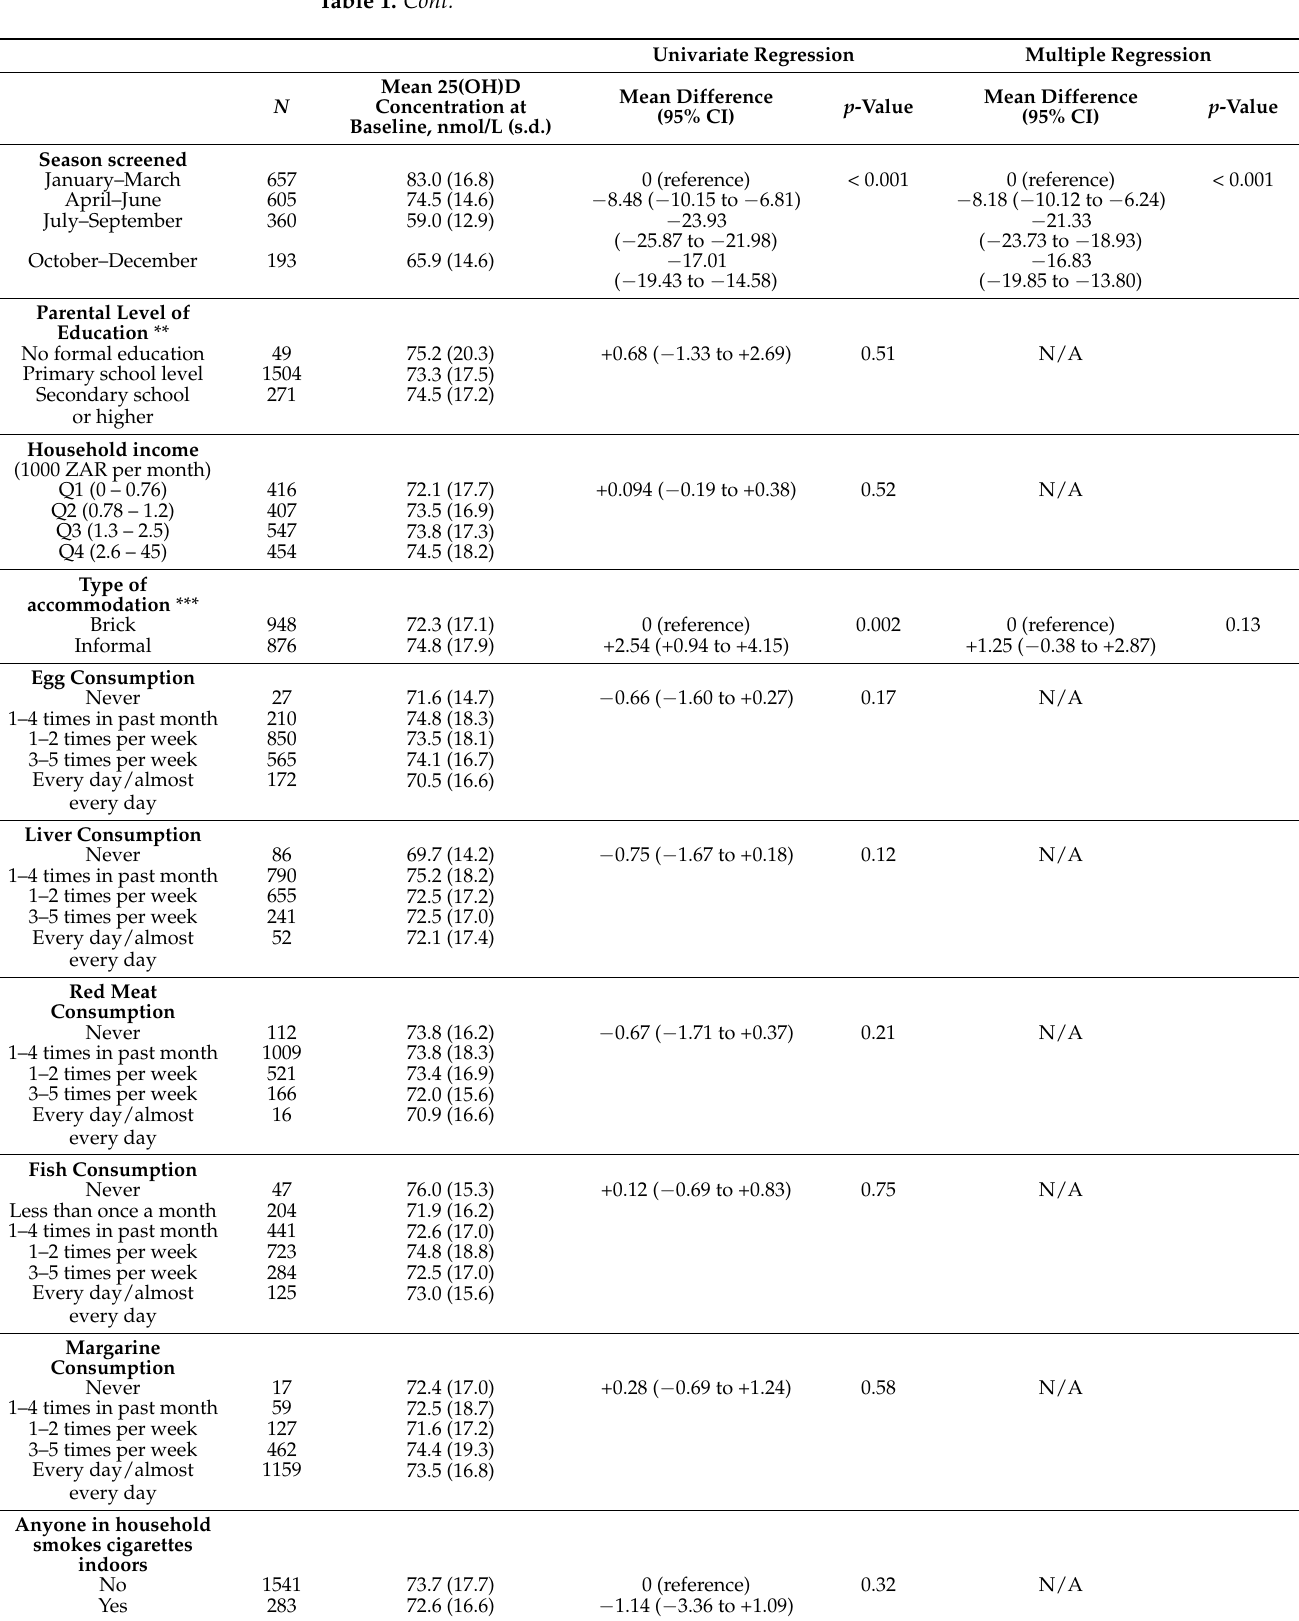
Table 1. Cont. Univariate Regression Multiple